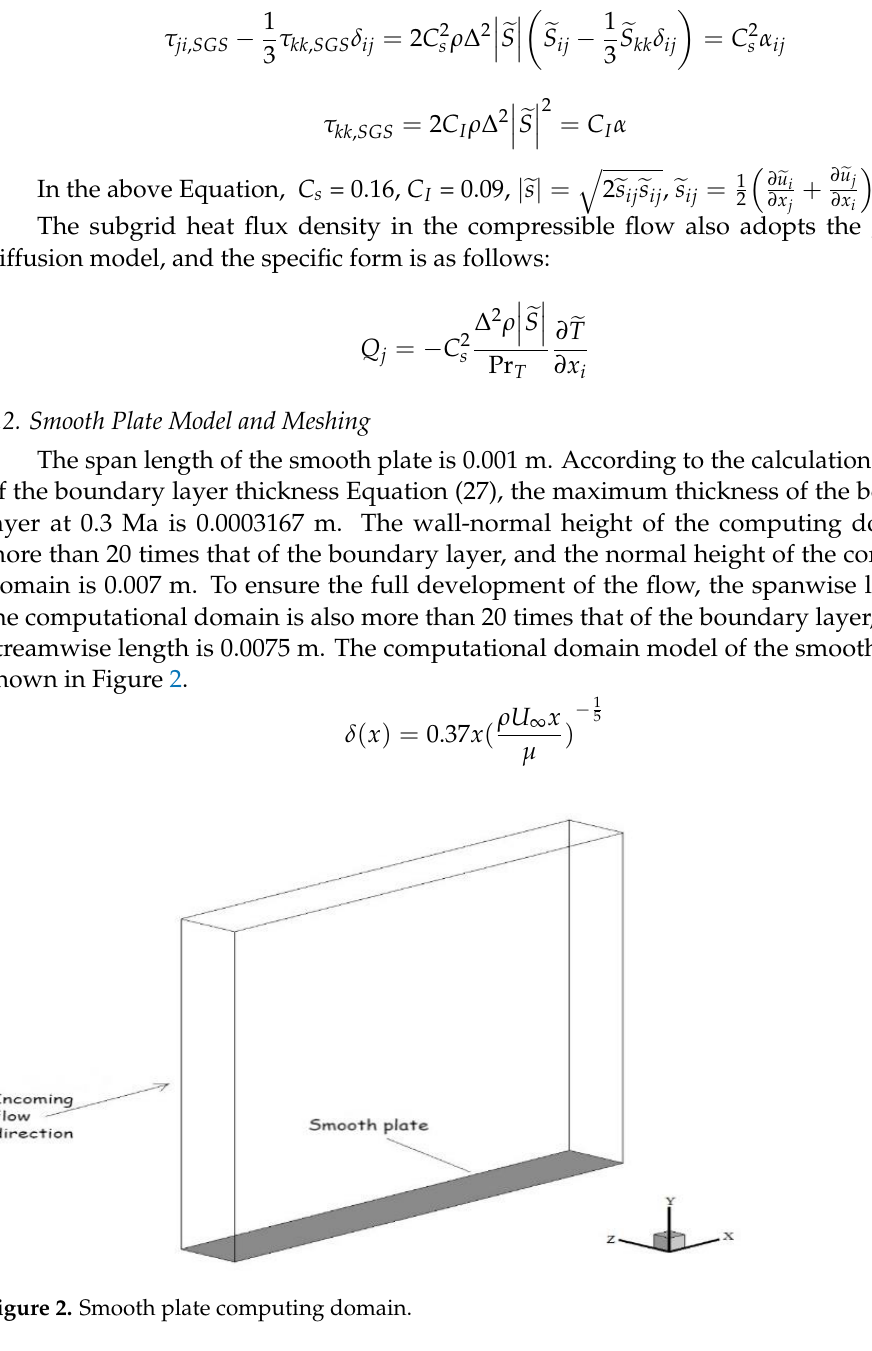
Figure 2. Smooth plate computing